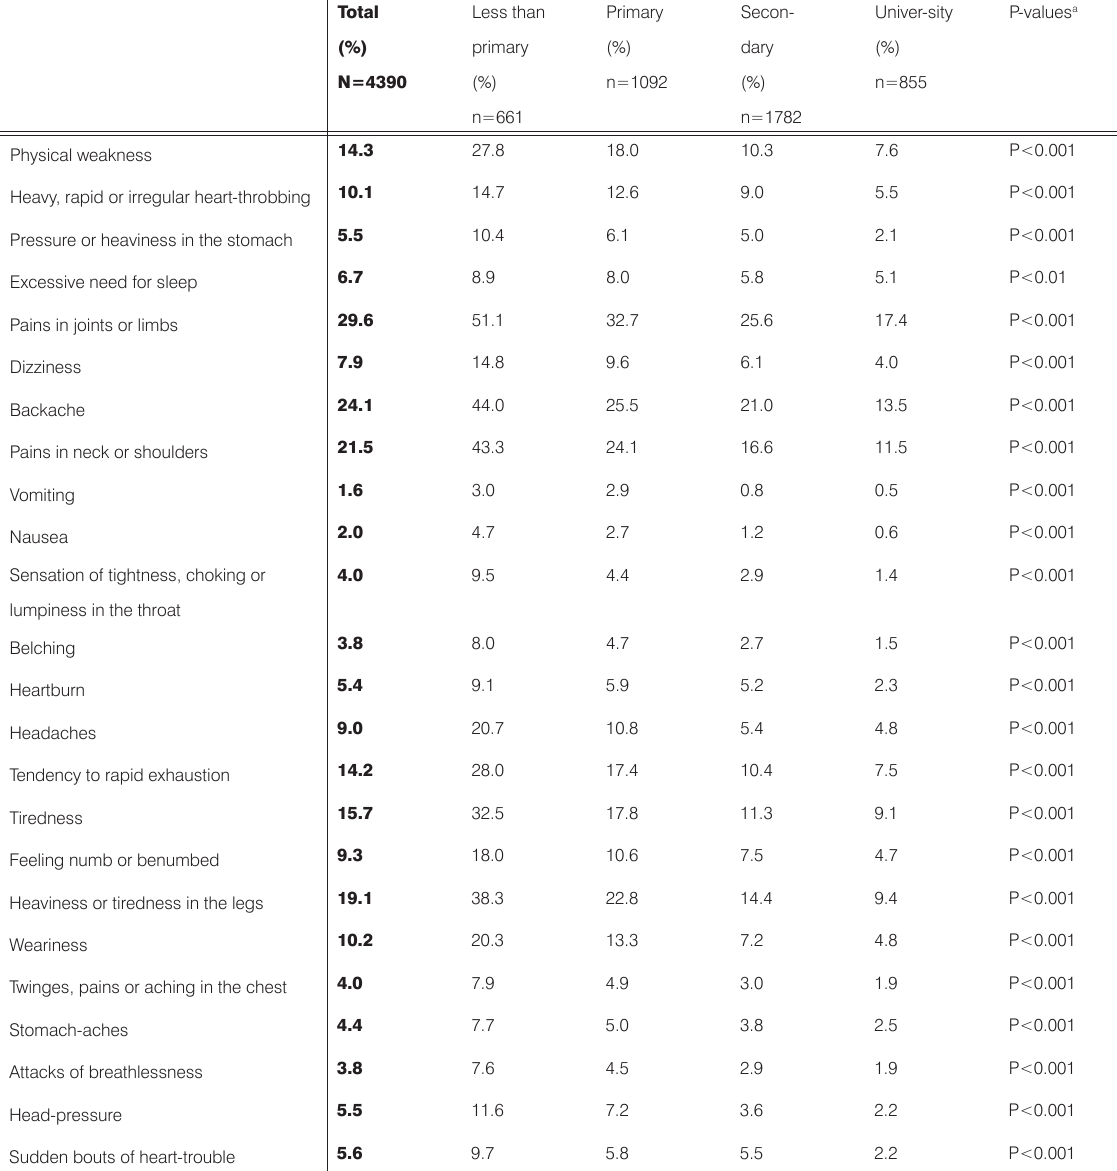
Table 2. Somatic complaints by item and education